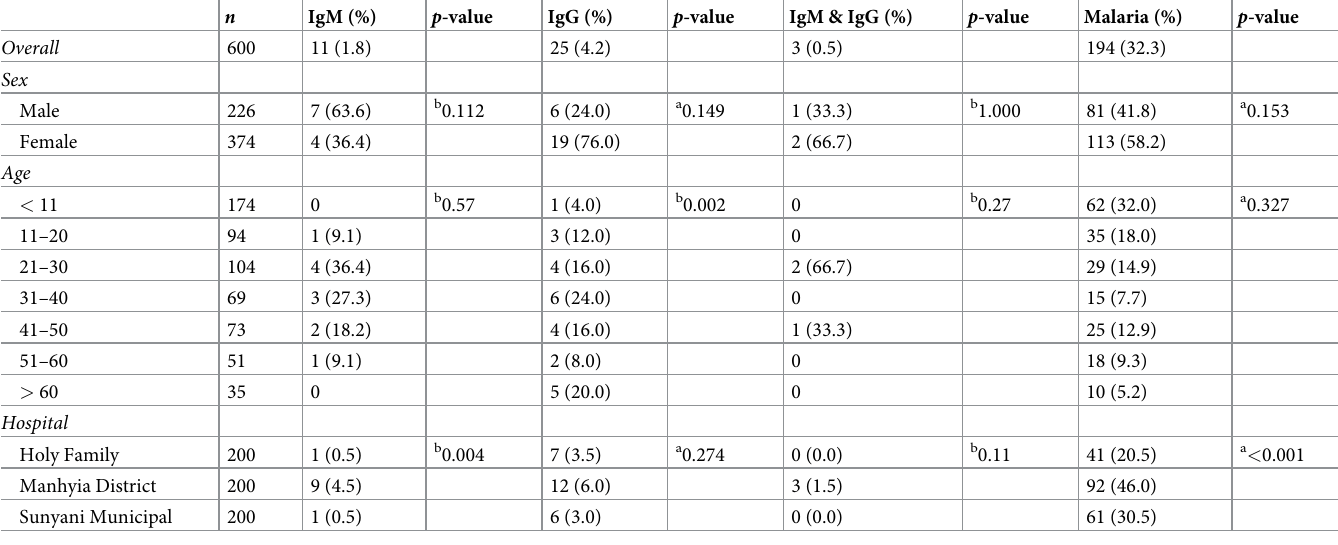
Table 1. Chikungunya seroprevalence and malaria status of study